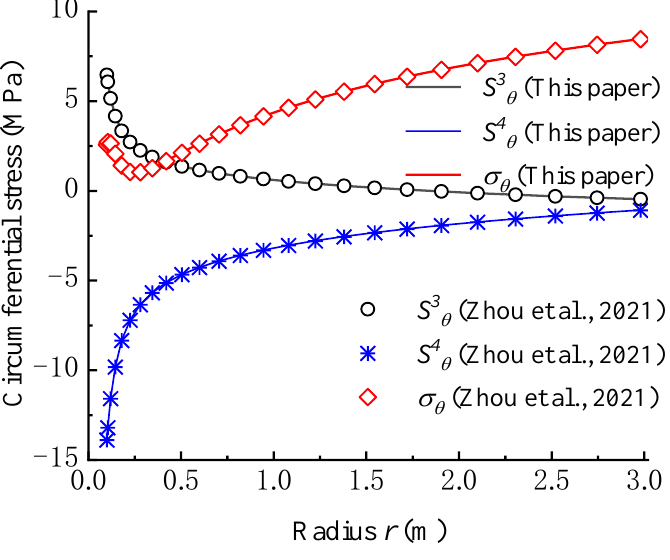
Figure 7. Verification of circumferential stress calculation model [36]. To verify the applicability of the circumferential stress calculation model proposed in this paper, the experimental results reported by Wang et al. (2017) [46] are employed. In their experiment, SC-CO 2 fluid was used as a fracturing fluid and the injection rate was lower than 80 mL/min, and then Niobrara shale cubes of 20 cm from Colorado were employed. As the viscosity of SC-CO 2 fluid is highly low, the seepage process of fluid during a fluid injection can be regarded as a steady state. In this case, the breakdown pressures of samples can be obtained from Equation (52). Table 5 shows a comparison between the experimental and predicted results. It can be found that the results calculated by using the H-F criterion (Equation (44)) are generally larger than those measured in the experiment. This means that the conventional model may overestimate the breakdown pressure of rocks during injection of fluid such as SC-CO 2 fluid. However, the breakdown pressures calculated from Equation (52) are relatively consistent with the experimental results, except for sample 2, where the calculation value is much lower than that measured in the experiment. If the difference between the initiation and breakdown pressures is considered [42], the predicted result in sample 2 is reliable. As recently reported, when SC-CO 2 fluid is used as a fracturing fluid, the observed initiation pressure is lower